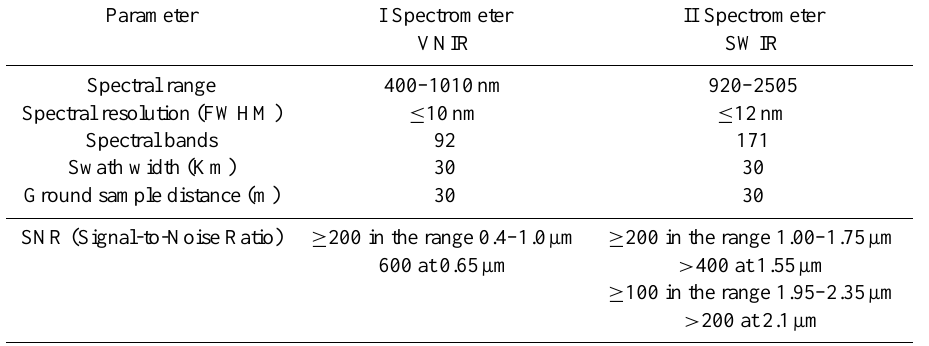
Table 3. PRISMA instrument specifications, available from the website: http://www.asi.it/files/The%20PRISMA%20mission.pdf.